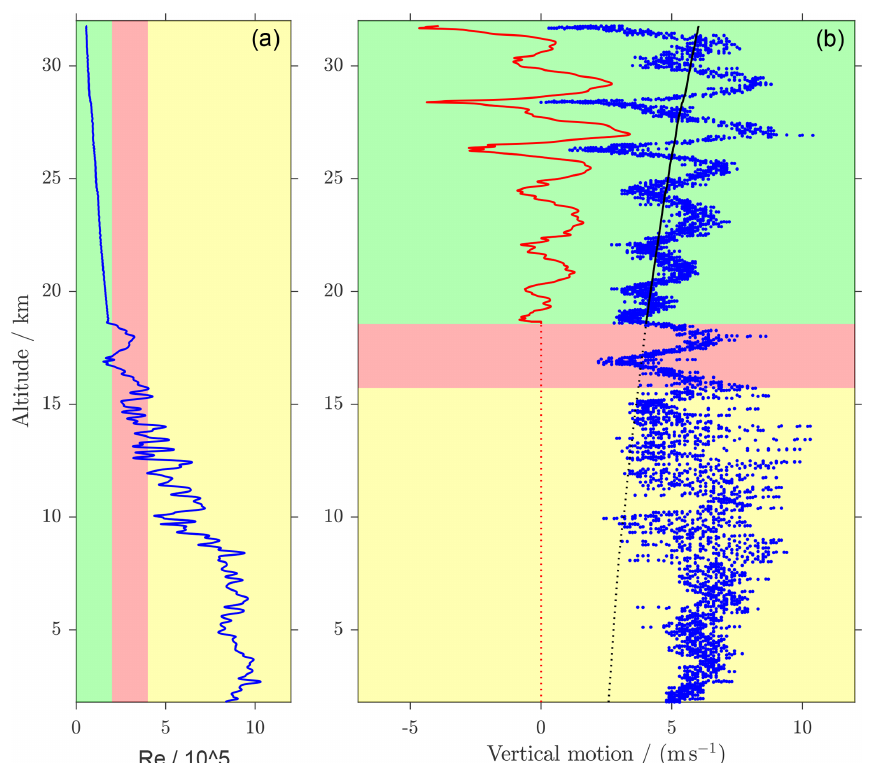
Figure A1. (a) Reynolds number of the flow around the balloon according to Eq. (A6). (b) Unfiltered ascent rates of the balloon (blue dots). Relative vertical velocity of the balloon w rel (black), and vertical winds according to Eq. (A5) (red). Vertical winds in the supercritical and critical Reynolds number regimes are set to zero because of changing drag coefficients. Retrieved relative vertical velocities underestimate the ascent rates in these regimes and are shown as a dashed black line. (a, b) Subcritical (green), critical (red) and supercritical (yellow) flow